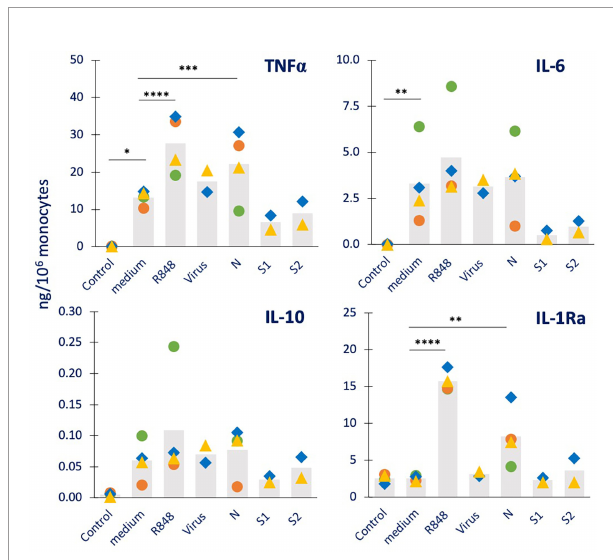
FIGURE 3 | Innate immune memory response to a viral challenge in human monocytes primed with inactivated SARS-CoV-2 or its proteins. Human monocytes isolated from blood of four individual donors (green, red, blue, and yellow symbols) were cultured for 24 h in culture medium alone or containing R848 (0.5 µg/mL, positive viral control), the inactivated SARS-CoV-2 virus (5 x10 5 copies), or the viral proteins N, S1, and S2 (all at 1 µg/mL). Cells were then washed and rested for 7 days in the absence of stimuli, then challenged for 24 h in fresh medium alone or containing 2.5 µg/mL R848. The production of TNF a (upper left), IL-6 (upper right), IL-10 (lower left) and IL-1Ra (lower right) was measured in the 24 h supernatants by ELISA. The values from cells that received no challenge are included in each panel as “ control ” and encompass the values obtained from primed and unprimed cells (which did not differ, con fi rming the return to baseline after the resting period). Data are presented as individual donors ’ values (colored symbols) and as mean of the individual values (gray columns). Statistical signi fi cance: * p < 0.05; ** p < 0.01; *** p < 0.001; **** p <